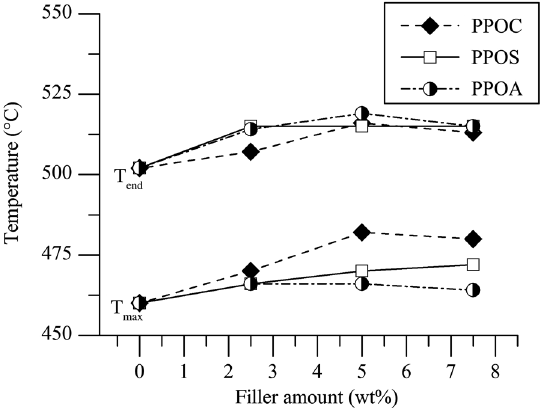
Figure 6 DTA curves of the investigated